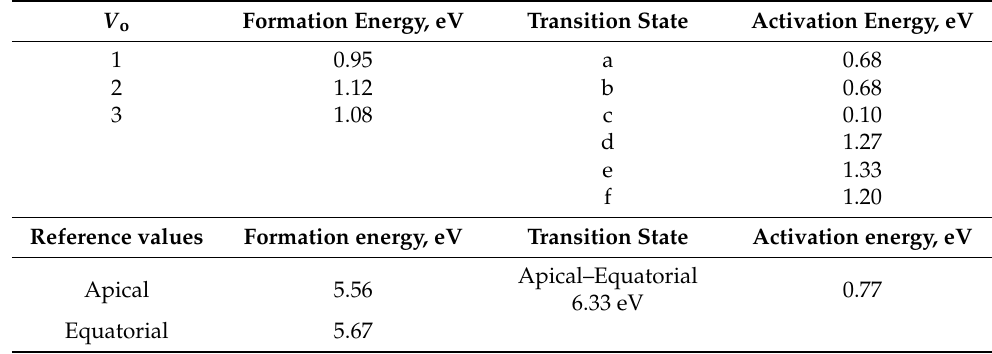
lower by 0.4 eV (Table 6). For the reference, two vacancies were modelled at the largest distance in the system from the (011) APB. All the formations, TS, as well as activation energies are higher than those within the interface. Table 6. Oxygen vacancy formation energy, as in Figure 4. Numbered stable states (Equation (2)) and activation (Equation (3)) energy, in